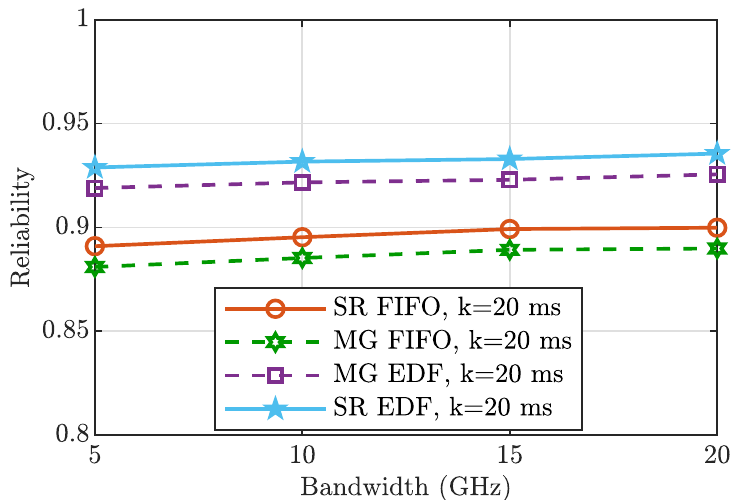
Figure 4. Reliability as a function of the bandwidth, considering p H , p G = 0.01, and p c , p d =